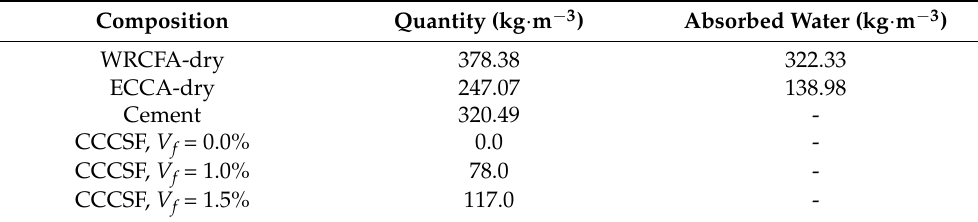
Table 1. Mixture proportions of a cubic meter of mixture [12].